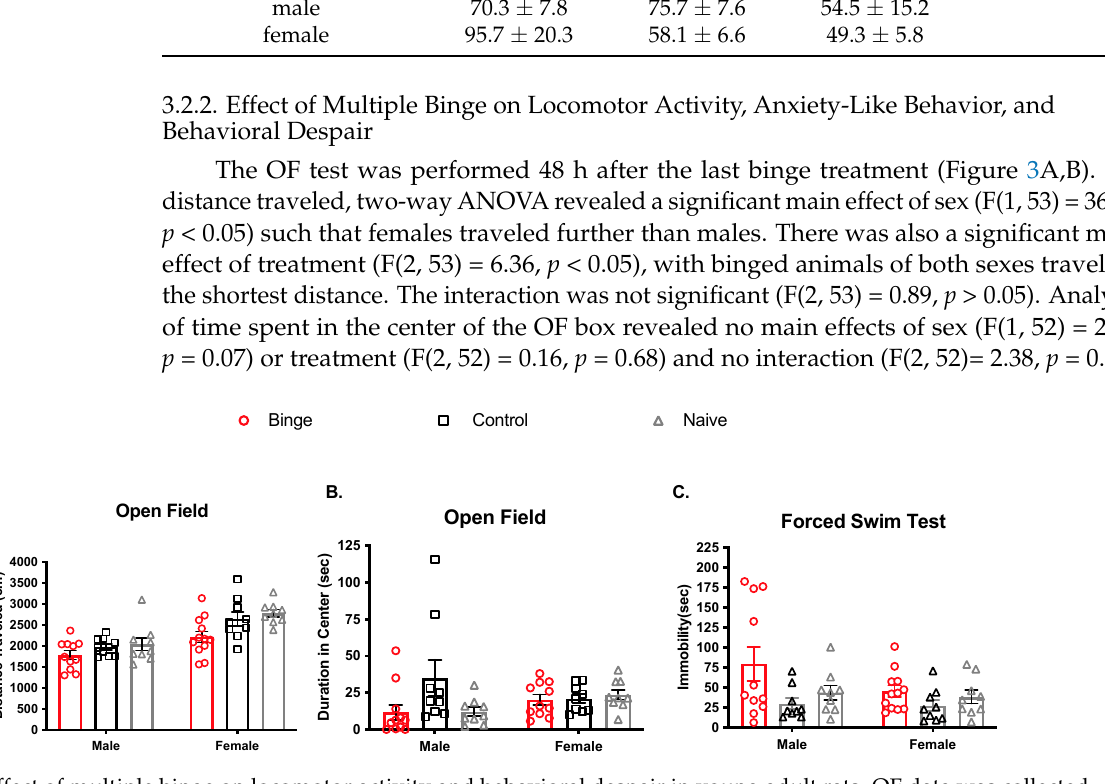
Figure 3. Effect of multiple binge on locomotor activity and behavioral despair in young adult rats. OF data was collected and analyzed from automatic tracking software in the first five minutes. ( A ) There was a main effect of sex, with females traveling further than males. ( B ) Time spent in the center of the OF did not differ by sex or binge exposure. ( C ) In the forced swim test, binged animals showed more immobility time than controls. Bars represent ± SEM from 9–12 subjects per group.